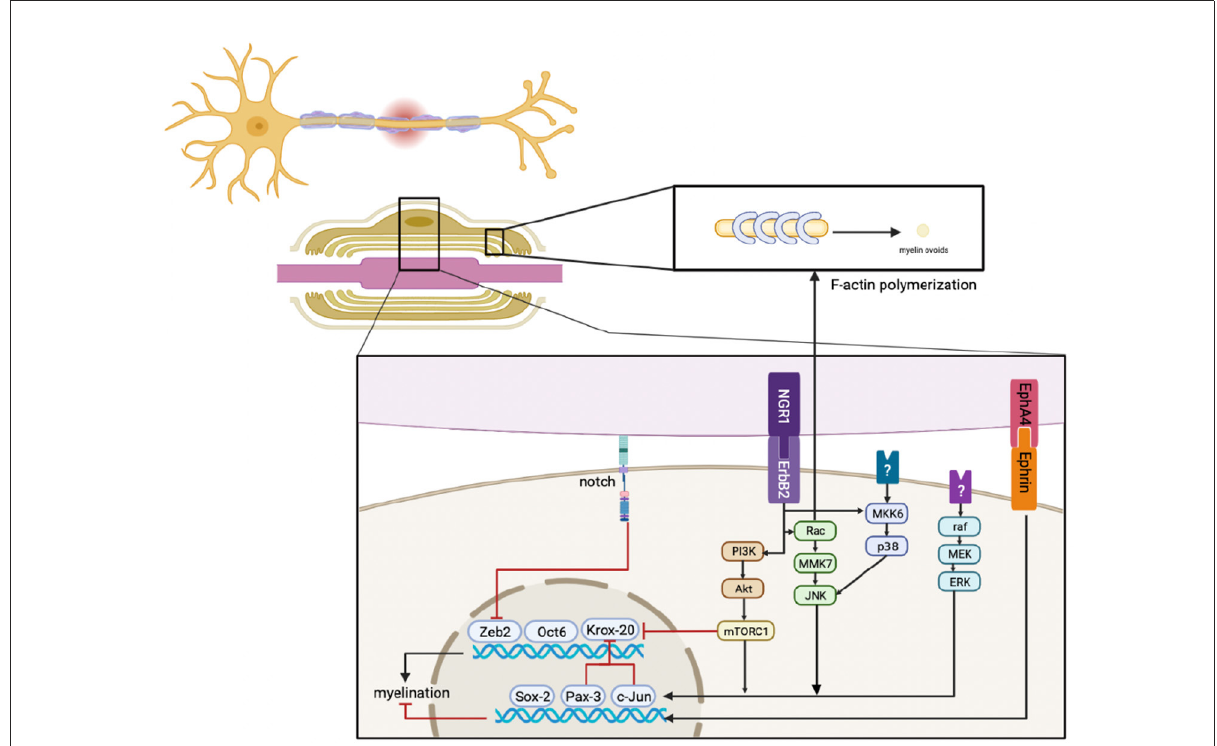
FIGURE2 Immediately after injury, ErbB2, MAPK, PI3K, Notch, and EphA4 signals respond in SCs, their crosstalk, and the downstream signaling pathways that regulate factors that mediate myelination. This results in the downregulation of pro-myelinating genes, including Zeb2, Oct6, and Krox20, and the upregulation of negative regulatory factors, including Sox-2, Pax-3, and c-Jun. In addition, activated Rac promotes F-actin polymerization to generate myelin ovoids. Myelin is also cleared during this